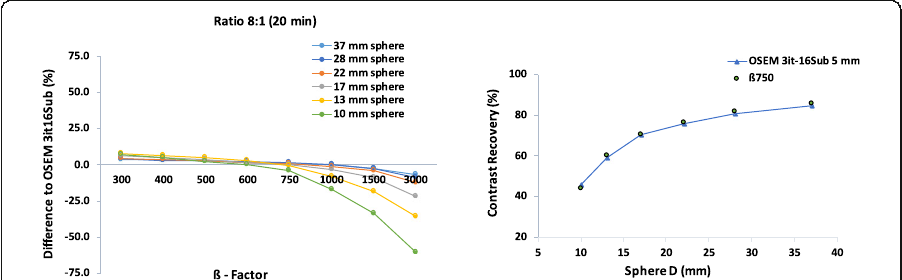
Fig. 2 Left : difference relative to the contrast recovery of TOF-OSEM (3 iterations, 16 subsets, post-filter 5.0 mm and PSF) at high count statistics (20 min) for each sphere size as a function of the regularization parameters. Right : comparison of the contrast recovery as a function of the sphere size of BSREM with β = 750 (including TOF and PSF) and OSEM for 20 min acquisition. All plots correspond to a contrast ratio of